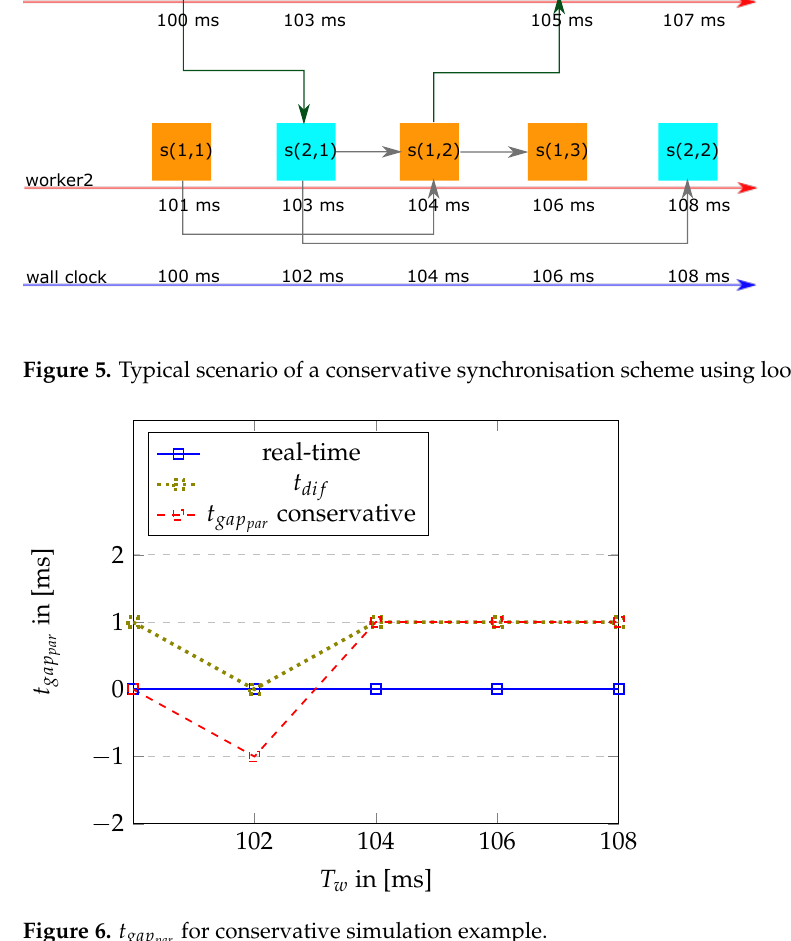
Figure 6. t gap for conservative simulation par